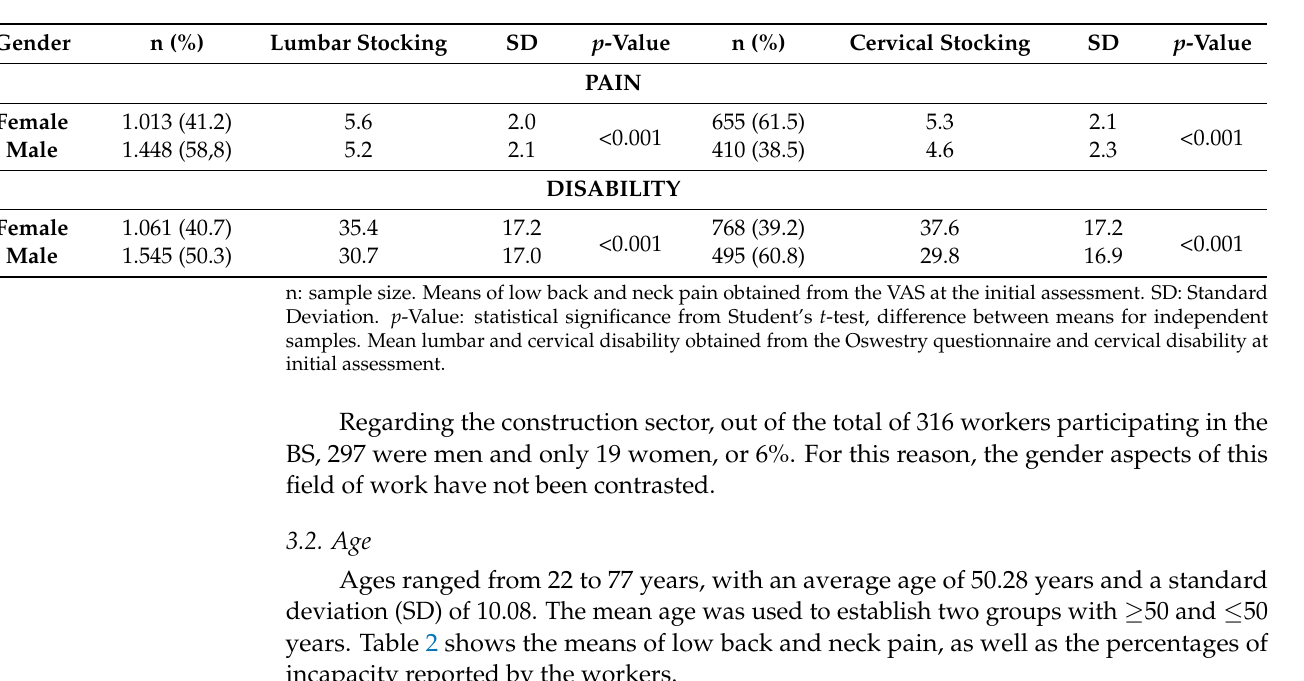
Table 1. First BS assessment: pain and disability by gender.